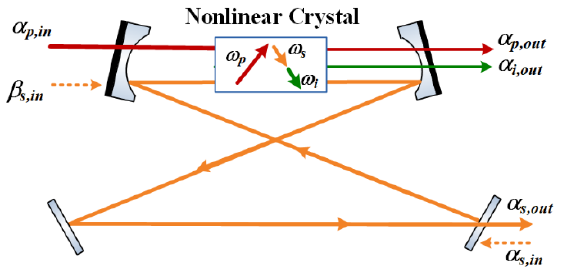
Figure 1. Schematic of the singly resonant optical parametric oscillator.